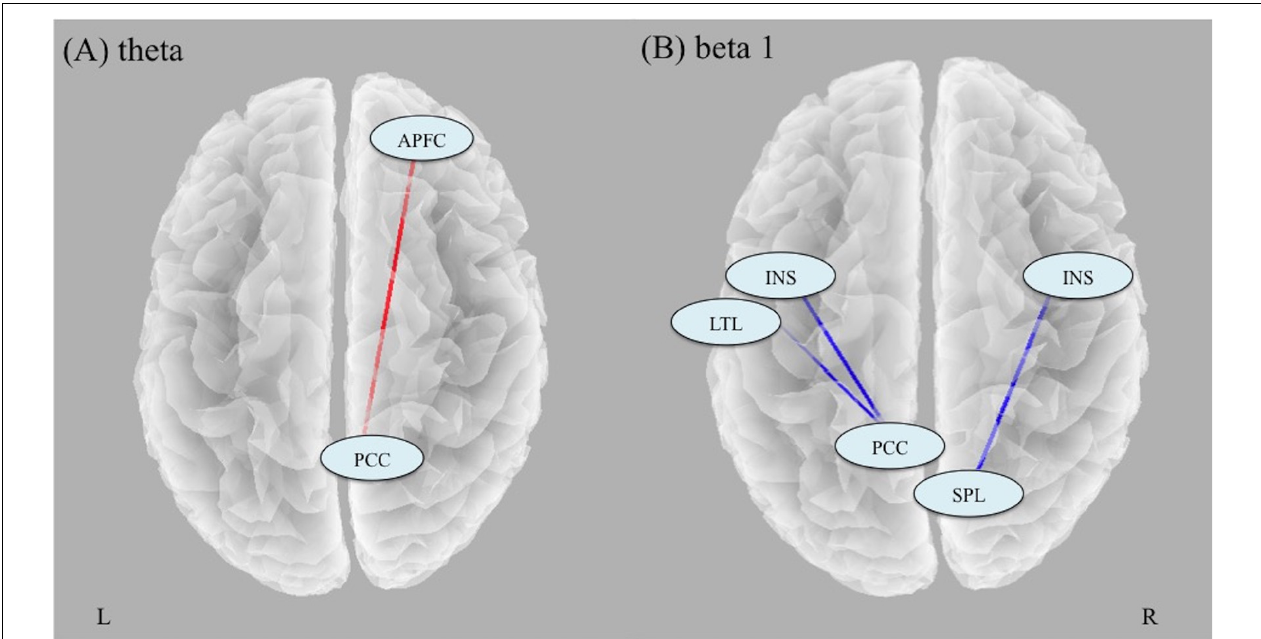
FIGURE 2 | Results of analyses of changes in lagged phase synchronization with ECT. (A) There was a significant increase in theta phase synchronization between the right APFC and the right PCC. (B) There were significant decreases in the beta 1 phase synchronization between the right INS and the right SPL, between the left PCC and the left INS, and between the left PCC and the left LTL. Abbreviation: APFC, anterior prefrontal cortex; PCC, posterior cingulate cortex; INS, insula; SPL, superior parietal lobule; LTL, lateral temporal